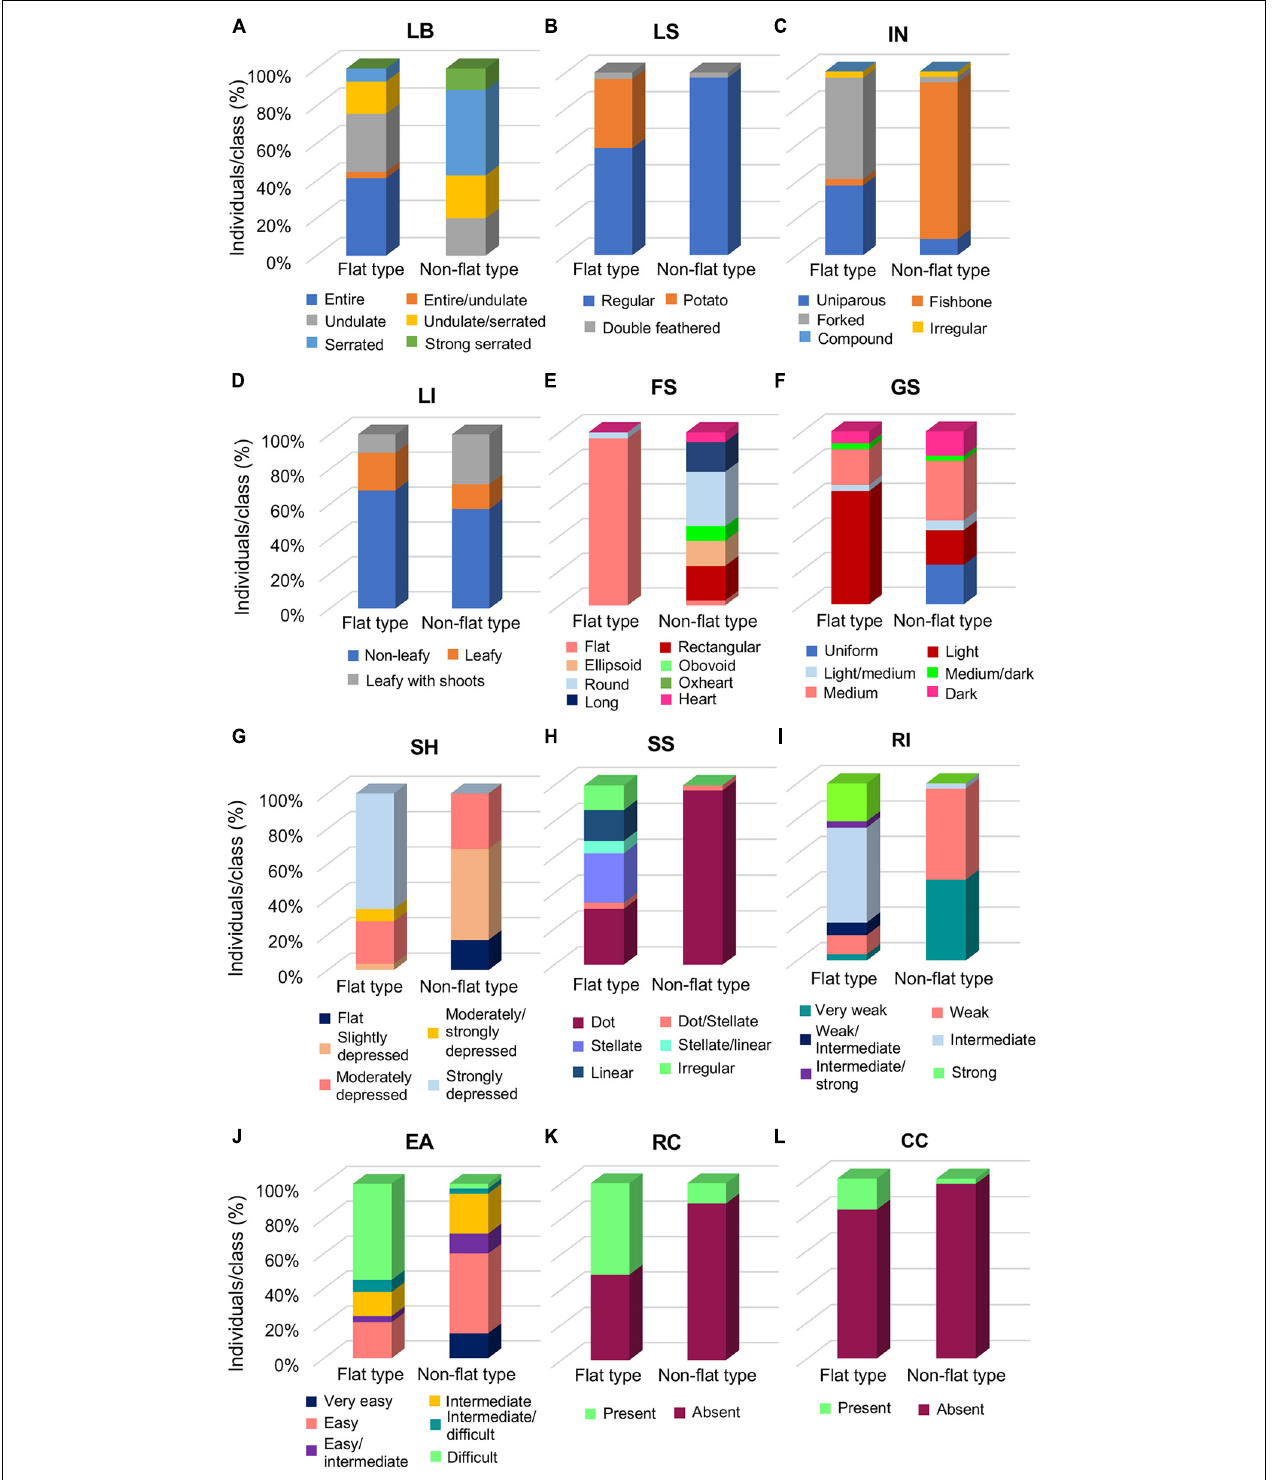
FIGURE 2 | Distribution of selected qualitative descriptors between the flat- and the non-flat-type groups of the 64 analyzed tomato accessions. (A) Leaf border (LB), (B) leaf shape (LS), (C) inflorescence type (IN), (D) leafiness (LI), (E) fruit shape (FS), (F) green shoulder (GS), (G) fruit shoulder shape (SH), (H) shape of scar (SS), (I) ribbing at calix end (RI), (J) easiness to detach (EA), (K) radial cracking (RC), and (L) concentric cracking (CC). Each histogram reports the percentage of individuals falling in the respective class for the considered trait.